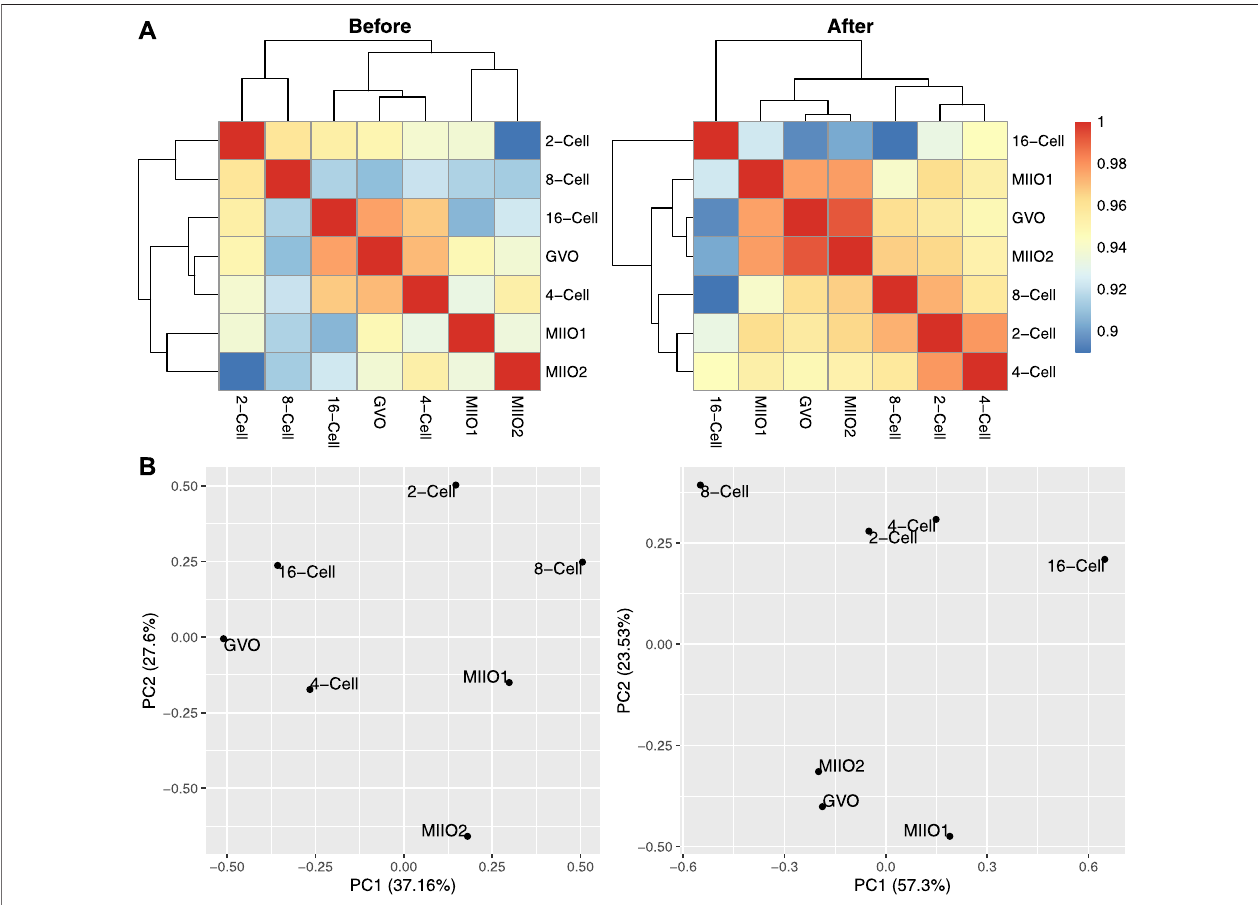
FIGURE 6 | Comparison of DNA methylation pro fi les of bovine oocytes and early-stage embryos before and after imputation. (A) : Pearson correlations among pro fi les; (B) : pro fi les embedded in the space spanned by the fi rst two principal components.